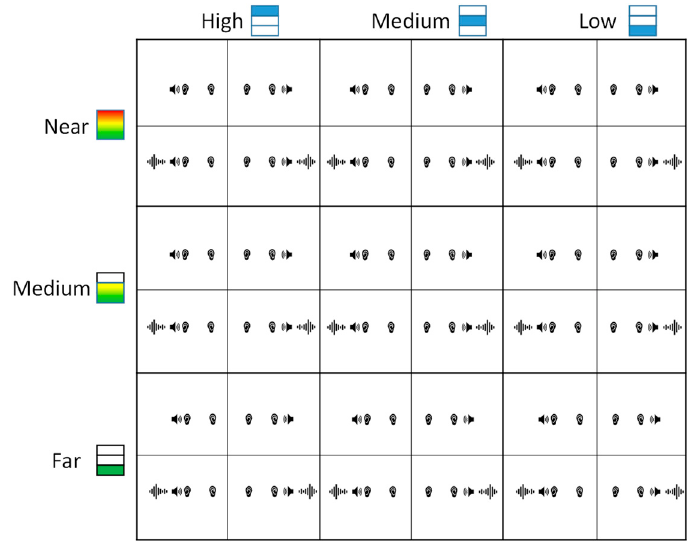
Figure 12. Auditory-assisted instruction program that incorporates all elements.